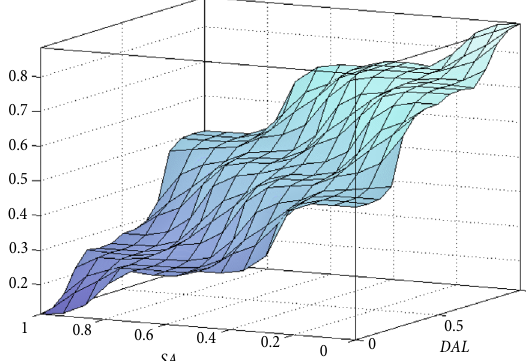
Fig. 9. Rule surface of FIS for the assessment of